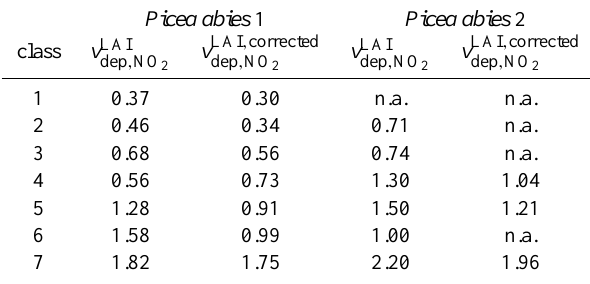
Table 5. Averages of NO 2 deposition velocities ( v LAI per ground area (LAI) and v LAI mms − 1 ) for NO 2 compensation point concentration when compen- sation point was definable. LAI of Spruce forest (EGER) =